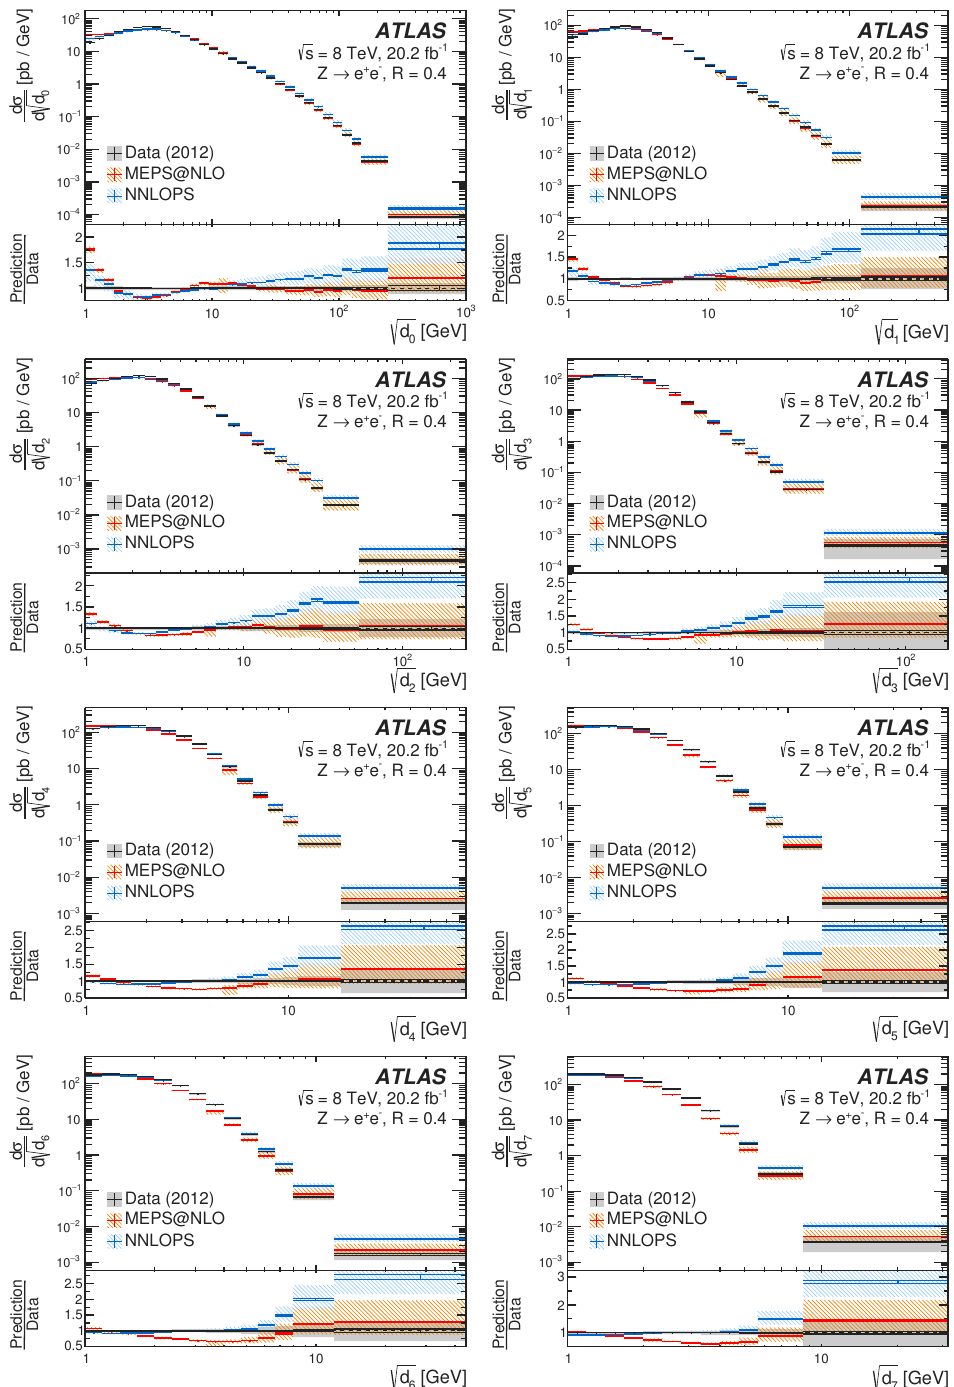
Figure 4. Charged-only distributions for the eight leading splitting scales in the electron chan- nel using the jet-radius parameter R = 0 : 4. The size of the error bars re(cid:13)ects the statistical uncertainty, while the combined statistical and systematic uncertainty is indicated by the grey band. Theoretical predictions from Sherpa with NLO multijet merging (\MEPS@NLO") and from Powheg + Pythia 8 with NNLO matching (\NNLOPS") are displayed including error bands for the generator